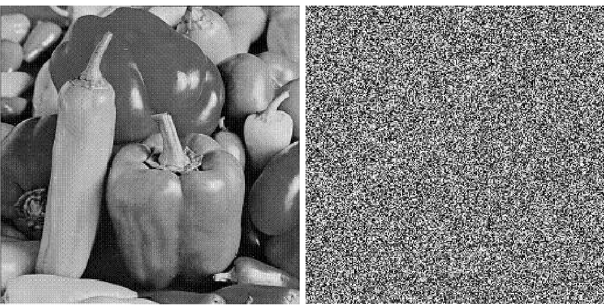
Figure 19. Decryption result of correct key 𝑘𝑒𝑦 and changed key 𝑘𝑒𝑦 1 .